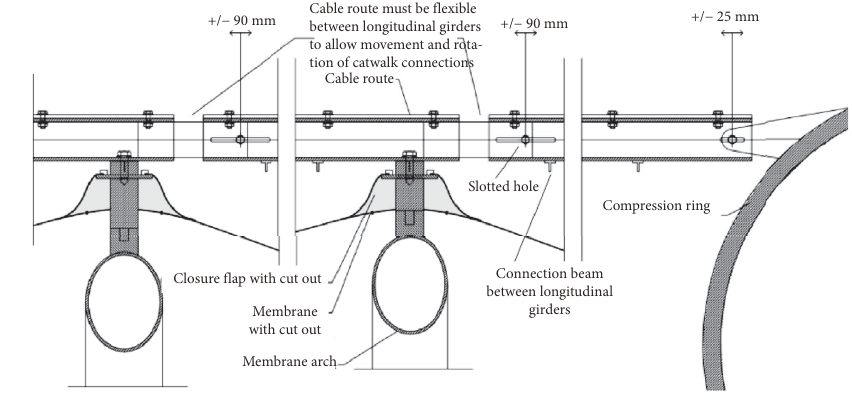
Figure 21: Details of the radial members.